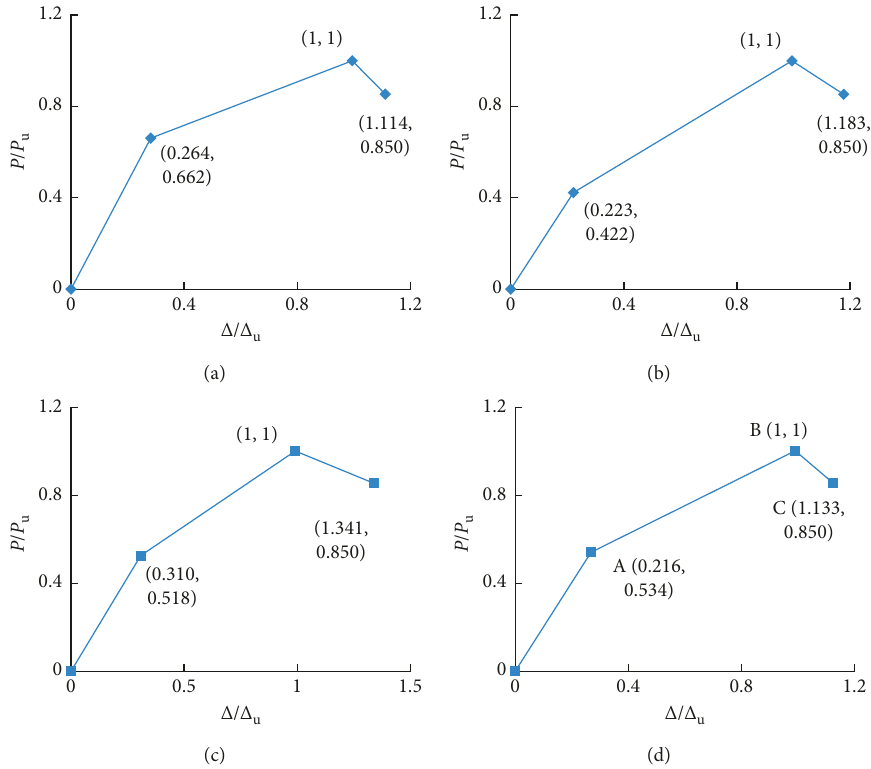
Figure 13: Normalized skeleton curves: (a) wall A1, (b) wall A2, (c) wall A3, and (d) all